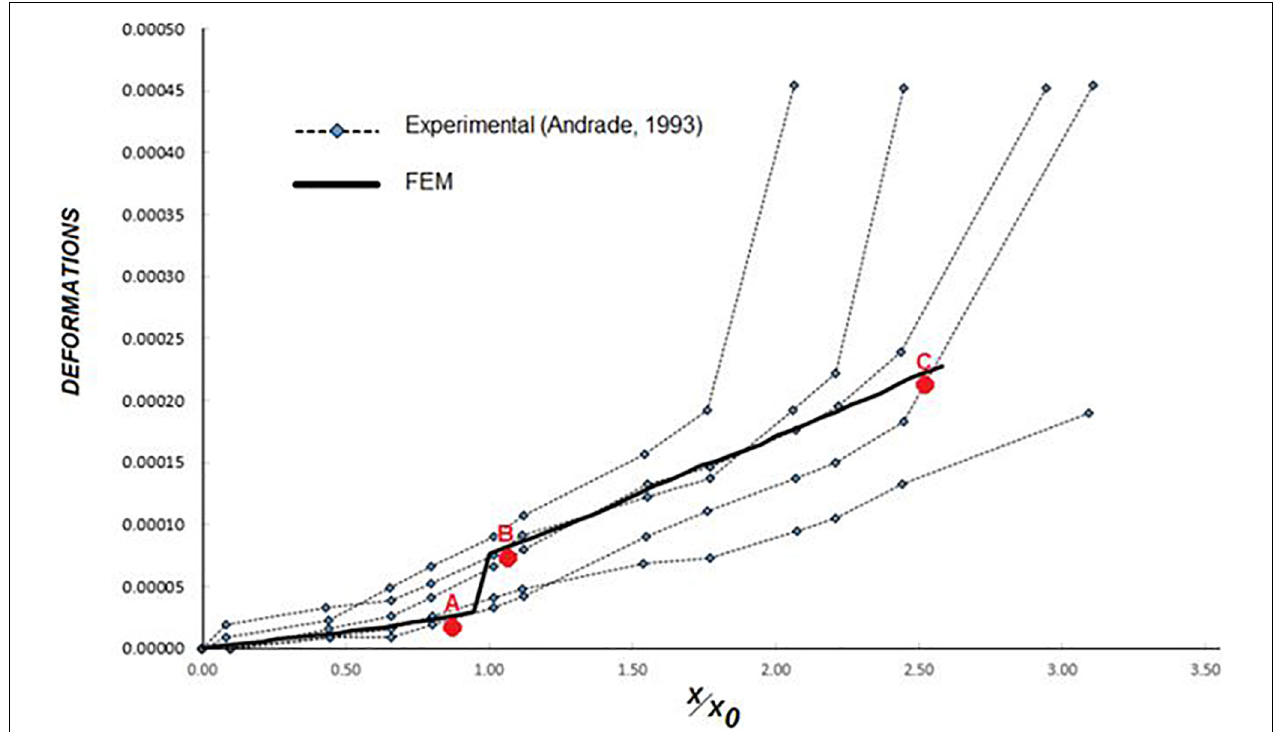
FIGURE 4 | Deformation vs. x / x 0 plot, showing the corrosion-induced cracking behavior. Comparison between experimental data taken from the literature and simulated data using the FEM model.